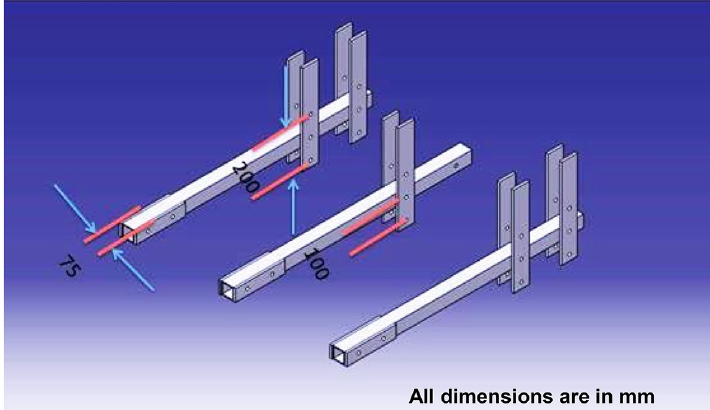
Figure 1. Isometric view of frame used in a developed